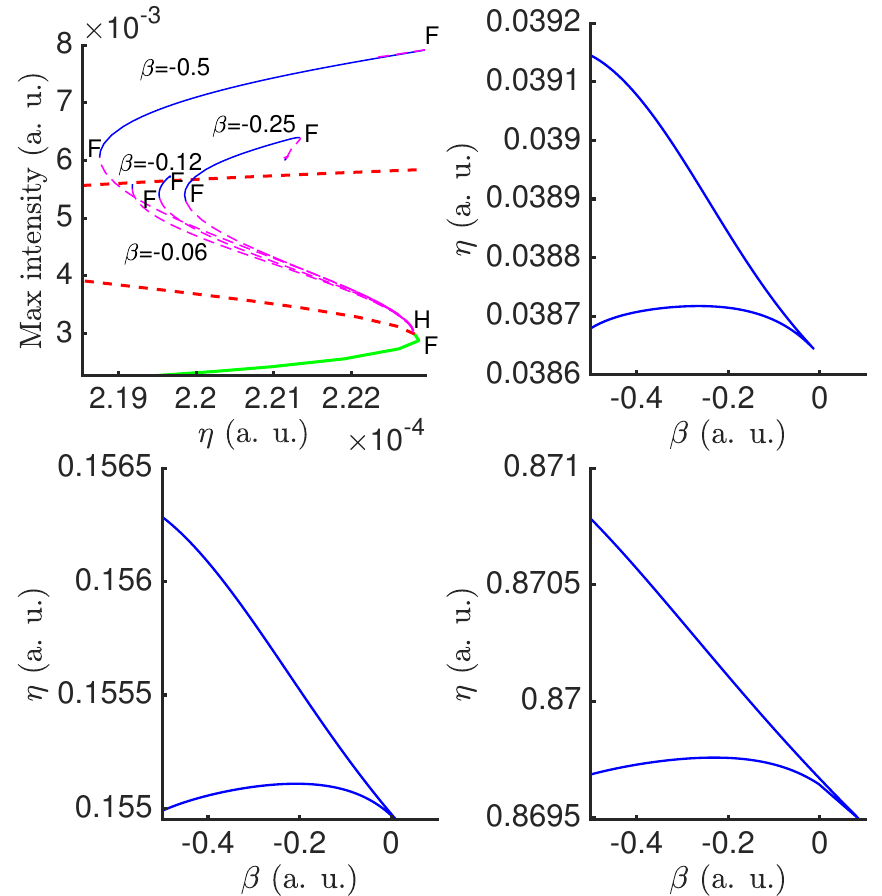
Figure 11. Top left: Bifurcation diagram of Equation (12) for ε = 0.05 and various values of β . Thick lines indicate CW solutions cut around S-shaped bifurcation curve, while thin lines correspond to periodic solutions. Solid (dashed) lines represent stable (unstable) solutions. Fold bifurcations are marked by F and Hopf bifurcations are marked by H. Other panels show fold bifurcations of the localized periodic solutions of (12) on the plane of two parameters, β and η . They correspond to ε = 0.3 ( top right ), ε = 0.5 ( bottom left ), and ε = 1.0 ( bottom right ). Other parameters are as in Figure